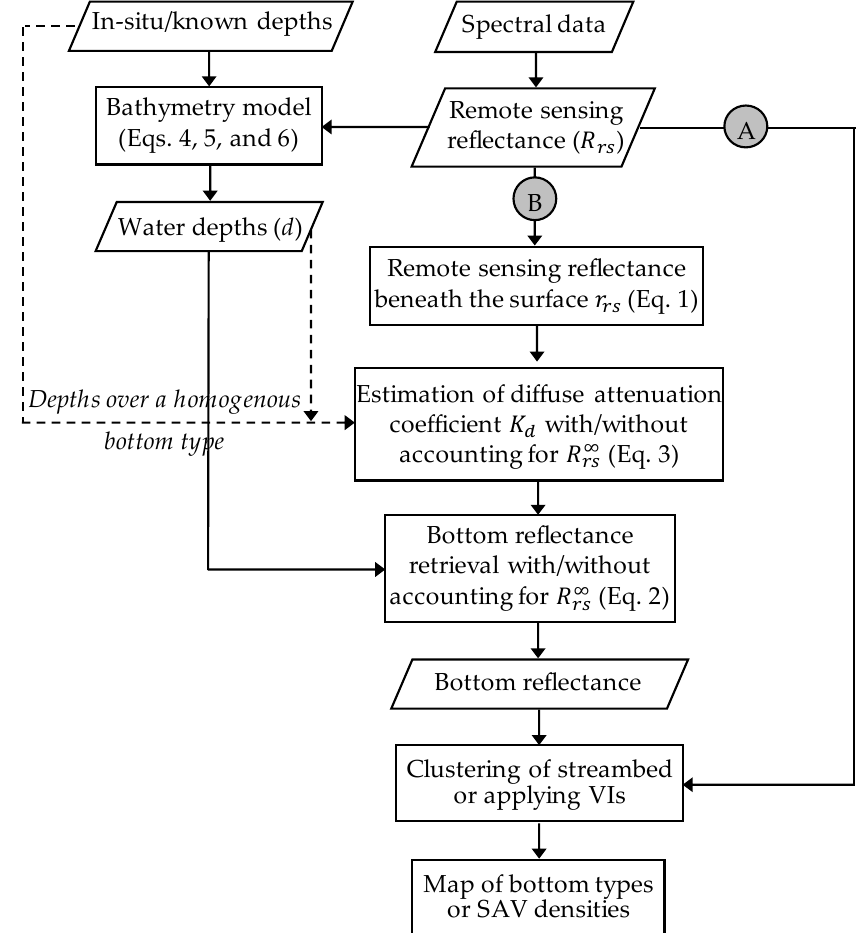
Figure 2. Flowchart for streambed mapping and delineation of SAV (A) before and (B) after water-column correction. The depth information required for K d estimations can be collected either in the field or derived from image/spectra (shown by dashed lines).